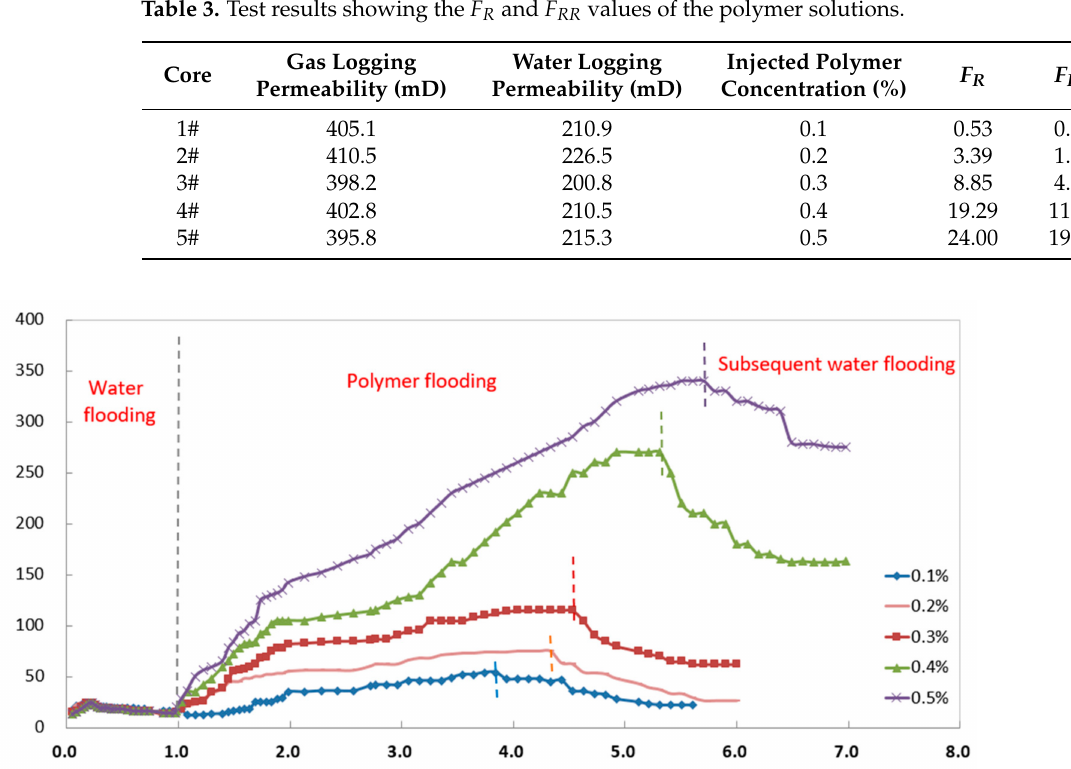
Figure 15. PV versus pressure